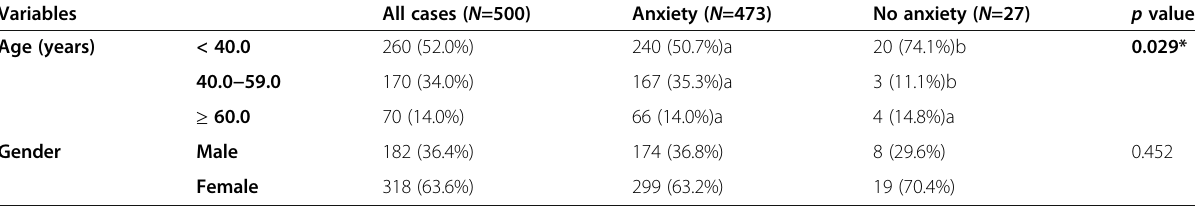
Table 2 Age and gender in all participants according to State Trait Anxiety Inventory (STAI) [25] Variables All cases ( N =500)